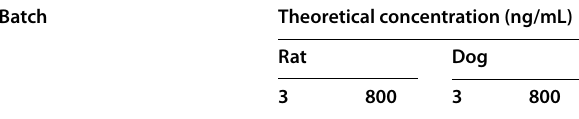
Table 4 Summary of stability studies for VEN in QC samples